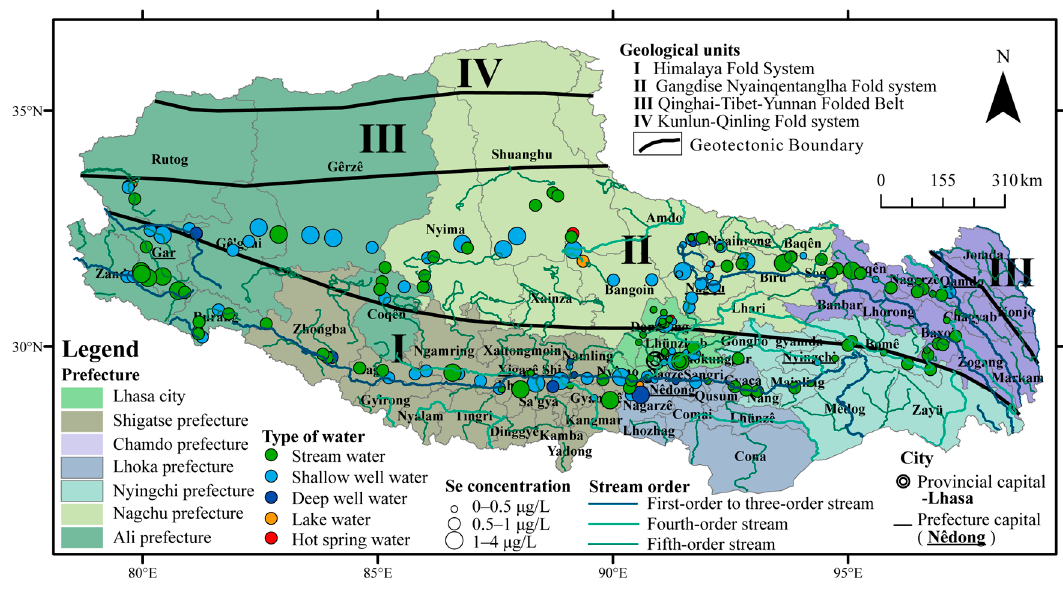
Figure 4. Administrative division, geological characteristics [26], and selenium concentrations of different types of water in Tibet.